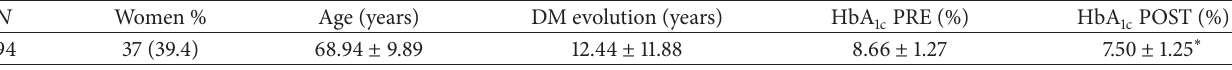
Table 1:Data of 94out of189 patients(group(B))whosetherapeutic changes wereperformed andwere reassessed3–6 monthsafter